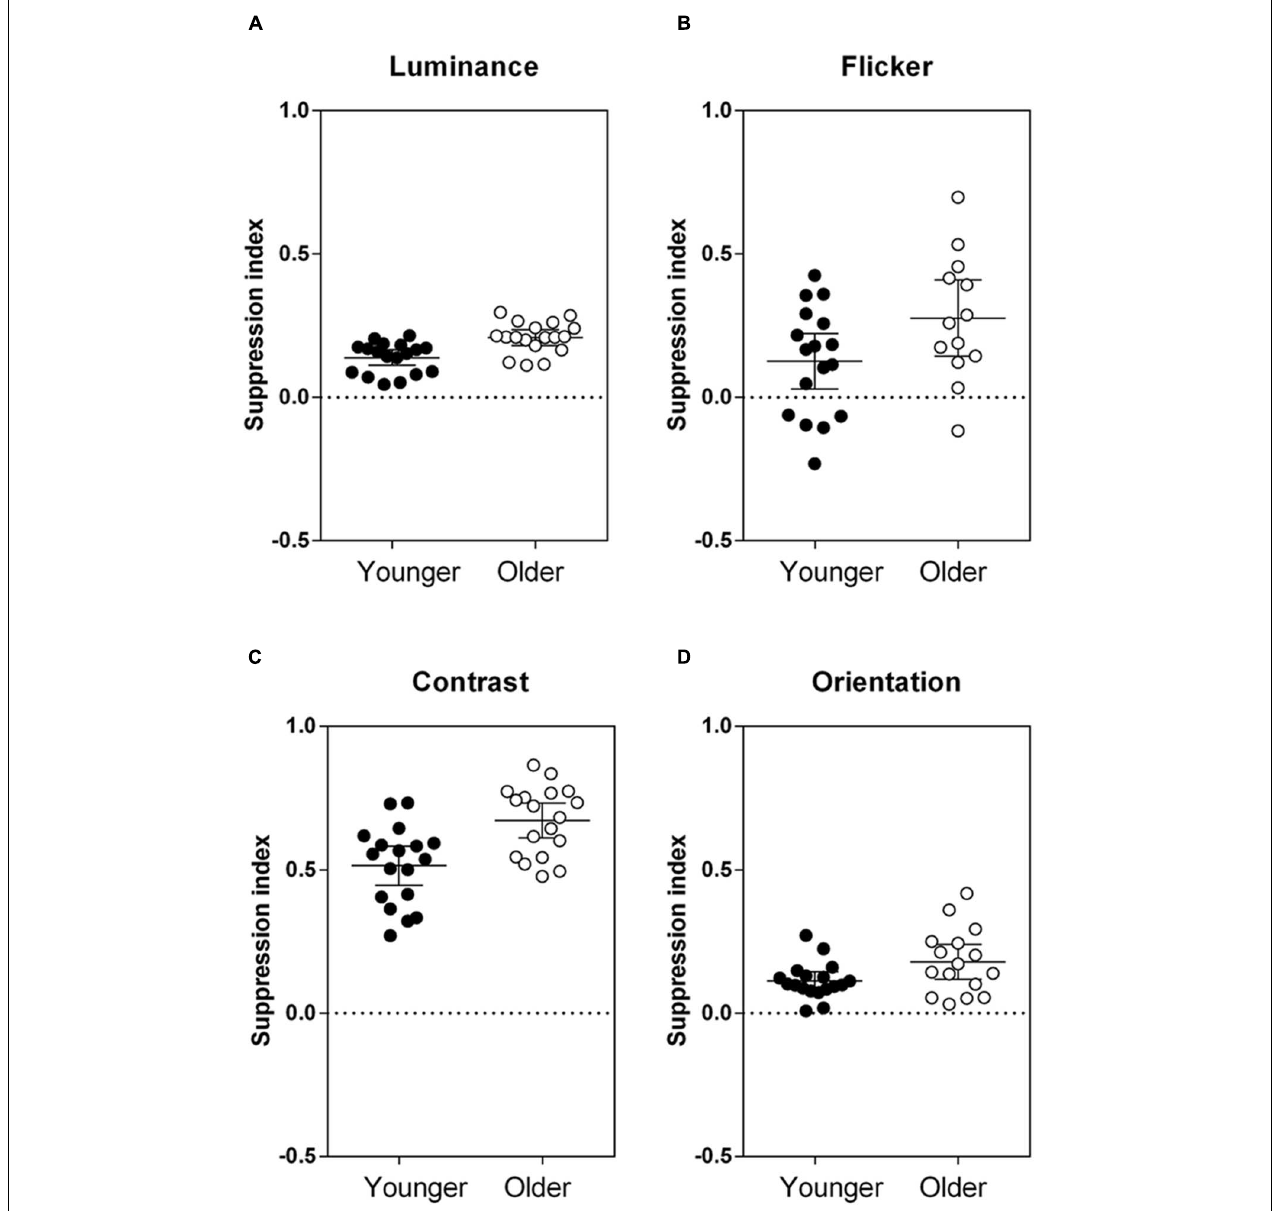
FIGURE 3 | Results from the four ‘surround’ conditions, where center–surround stimuli were defined by (A) luminance, (B) flicker, (C) contrast, and (D) orientation. Group mean and individual suppression indices (1 – PSE ‘surround’/PSE ‘no surround’) are plotted, where a positive suppression index indicates suppression, a negative index indicates facilitation, and an index of 0 indicates no effect of the surround. Error bars are the 95% confidence limits of the mean. PSE, point of subjective equality. The two groups were significantly different from each other across all tasks, F (1,36.40) = 22.02, p <